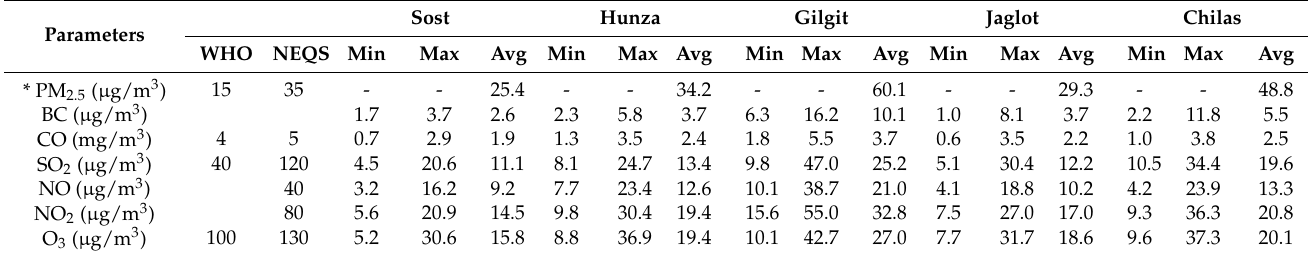
Table 2. Concentrations of selected air pollutants in GB cities during winter, 2019.